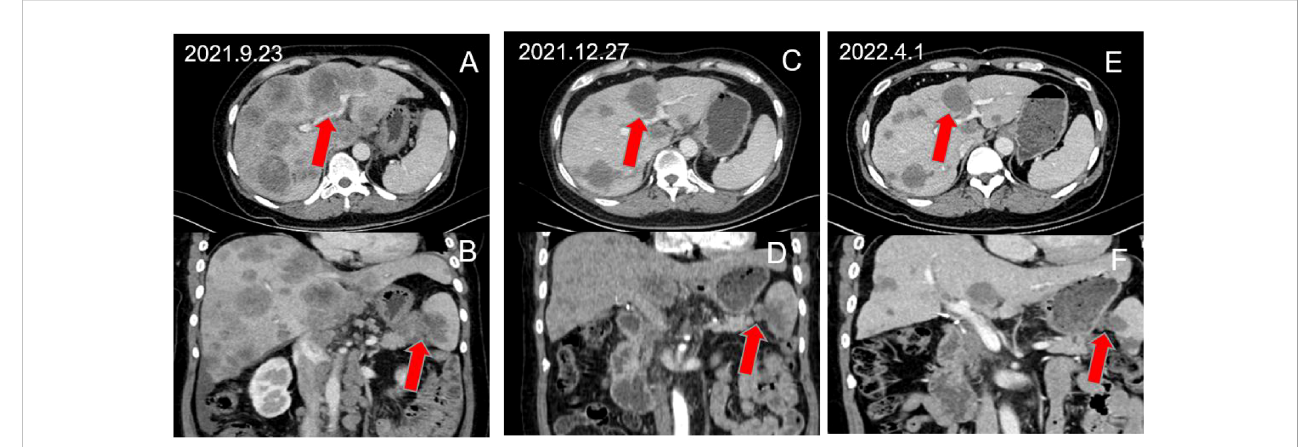
FIGURE 2 A 52-year-old female patient with advanced PC with multiple liver metastases achieved partial response after receiving A+GS regimen therapy. (A, B) show the pre-treatment baseline images, (C, D) show the images after 3 cycles of treatment, and (E, F) show the images after 6 cycles of treatment.